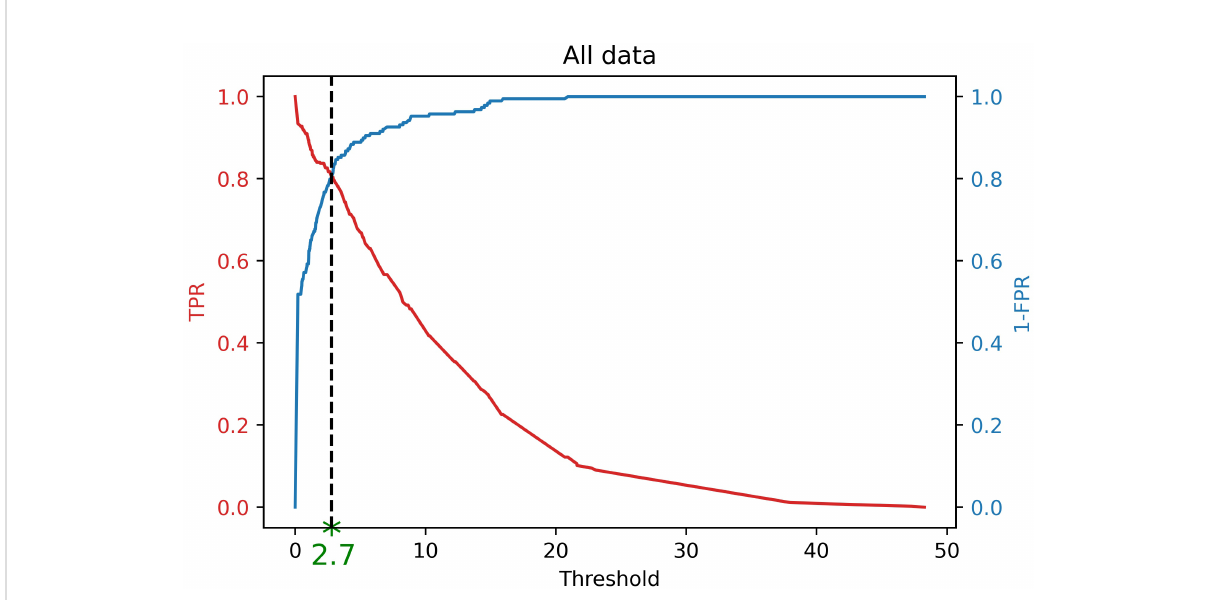
FIGURE 4 Finding optimal threshold ( T sp = 2.7) of DL results for fi nding One-Hot encoding using ROC analysis. If the severity percentage value for a speci fi c severity level is more than this threshold, it is encoded as 1, otherwise,0. Therefore, this encoded value shows the occurrence of that severity level in an image based on the DL